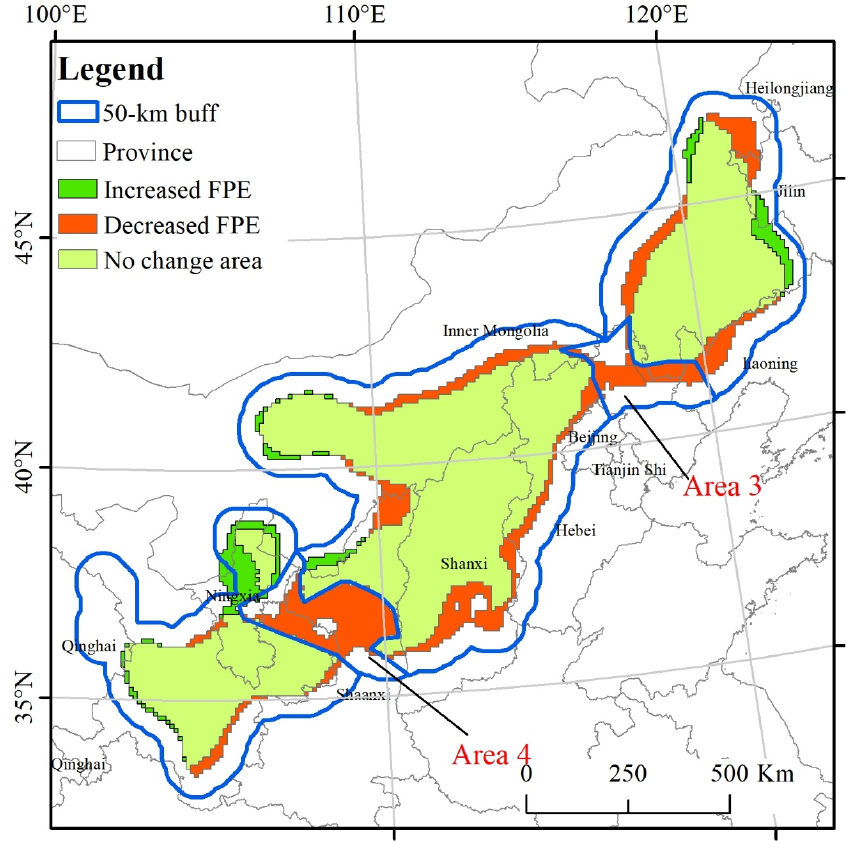
Figure 5. Map of 50-km buffer zone of the FPE in